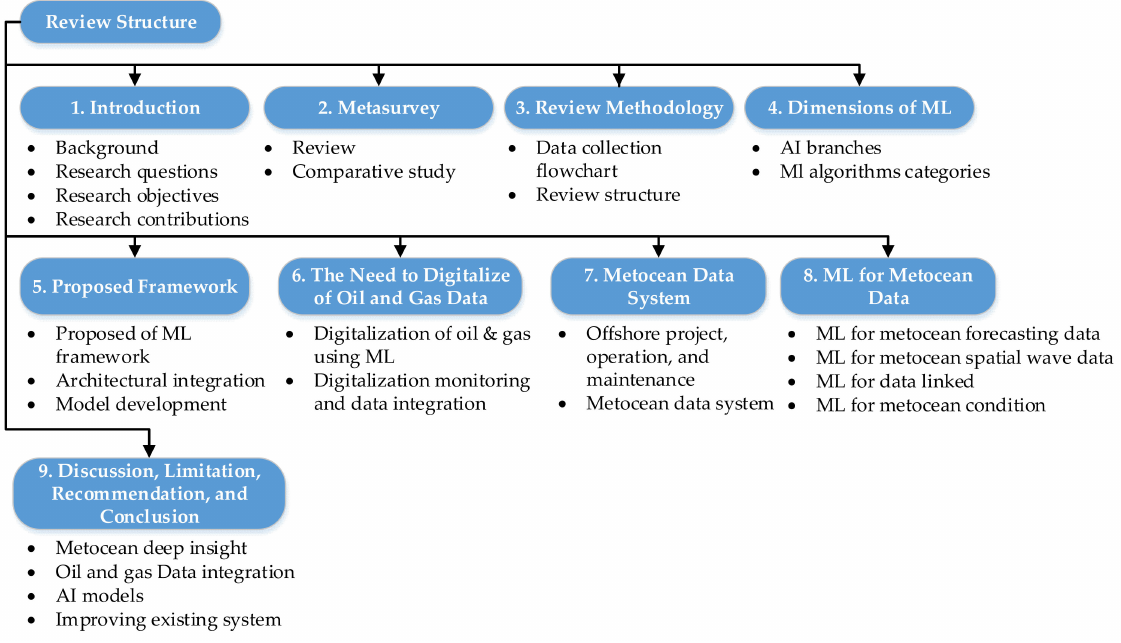
Figure 2. Structure of the review